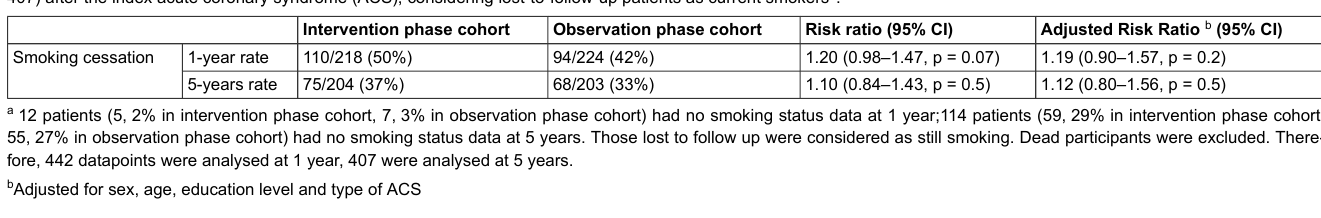
Table S3: Smoking cessation prevalence comparing participants in the smoking cessation intervention phase cohort with the observation phase cohort at 1 year (n = 442) and 5 years (n = 407) after the index acute coronary syndrome (ACS), considering lost-to-follow-up patients as current smokers a